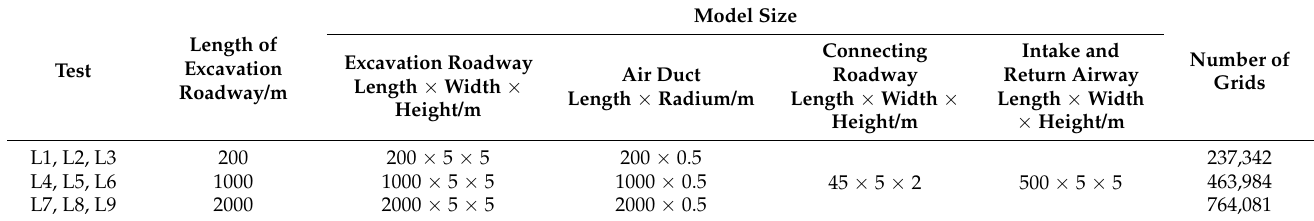
Figure 4. Physical model and its meshing. Table 2. Physical model of the roadway.